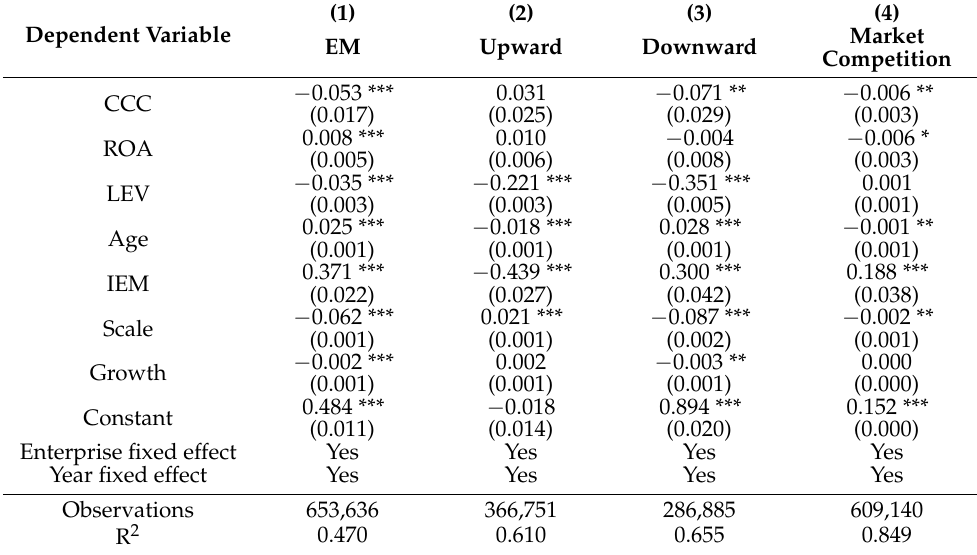
Table 2. The regression